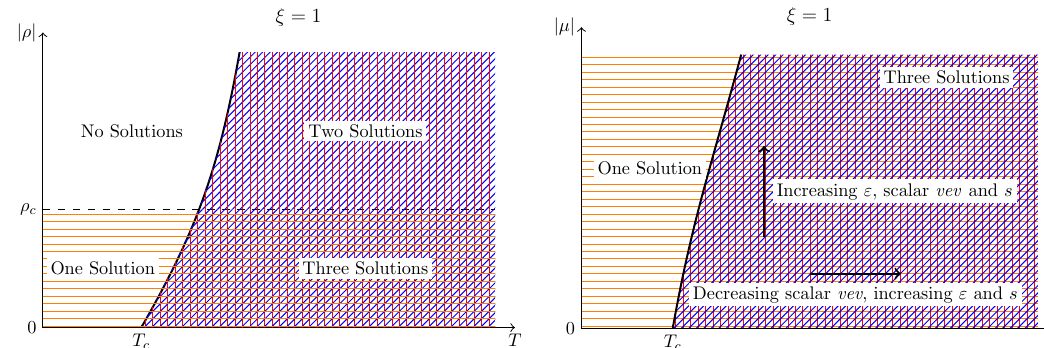
Figure 6 . Number of electric solutions of Theory II with (cid:24) = 1 as a function of charge density (cid:26) and temperature T ( left plot ), or chemical potential (cid:22) and temperature T ( right plot ). The plots apply to any (cid:12)xed j p j > 0. There are three distinct solutions, indicated respectively by horizontal orange lines, red vertical lines, and blue diagonal lines. We refer to these solutions as ‘orange’, ‘red’ and ‘blue’, respectively. The orange solution exists for all temperatures provided the (absolute p value of the) charge density is below the critical value (cid:26) c = ‘p 2 = 2 2. However, this solution is dynamically unstable since it always has negative energy density. Moreover, where it coexists with the red and blue solutions it has the largest radius, but it is thermodynamically unstable. The p red and blue solutions appear simultaneously above a critical temperature T c (cid:21) j p j = 2 2 (cid:25)‘ and are always dynamically stable, since they have positive energy density. The blue solutions have larger radius than the red ones and are thermodynamically